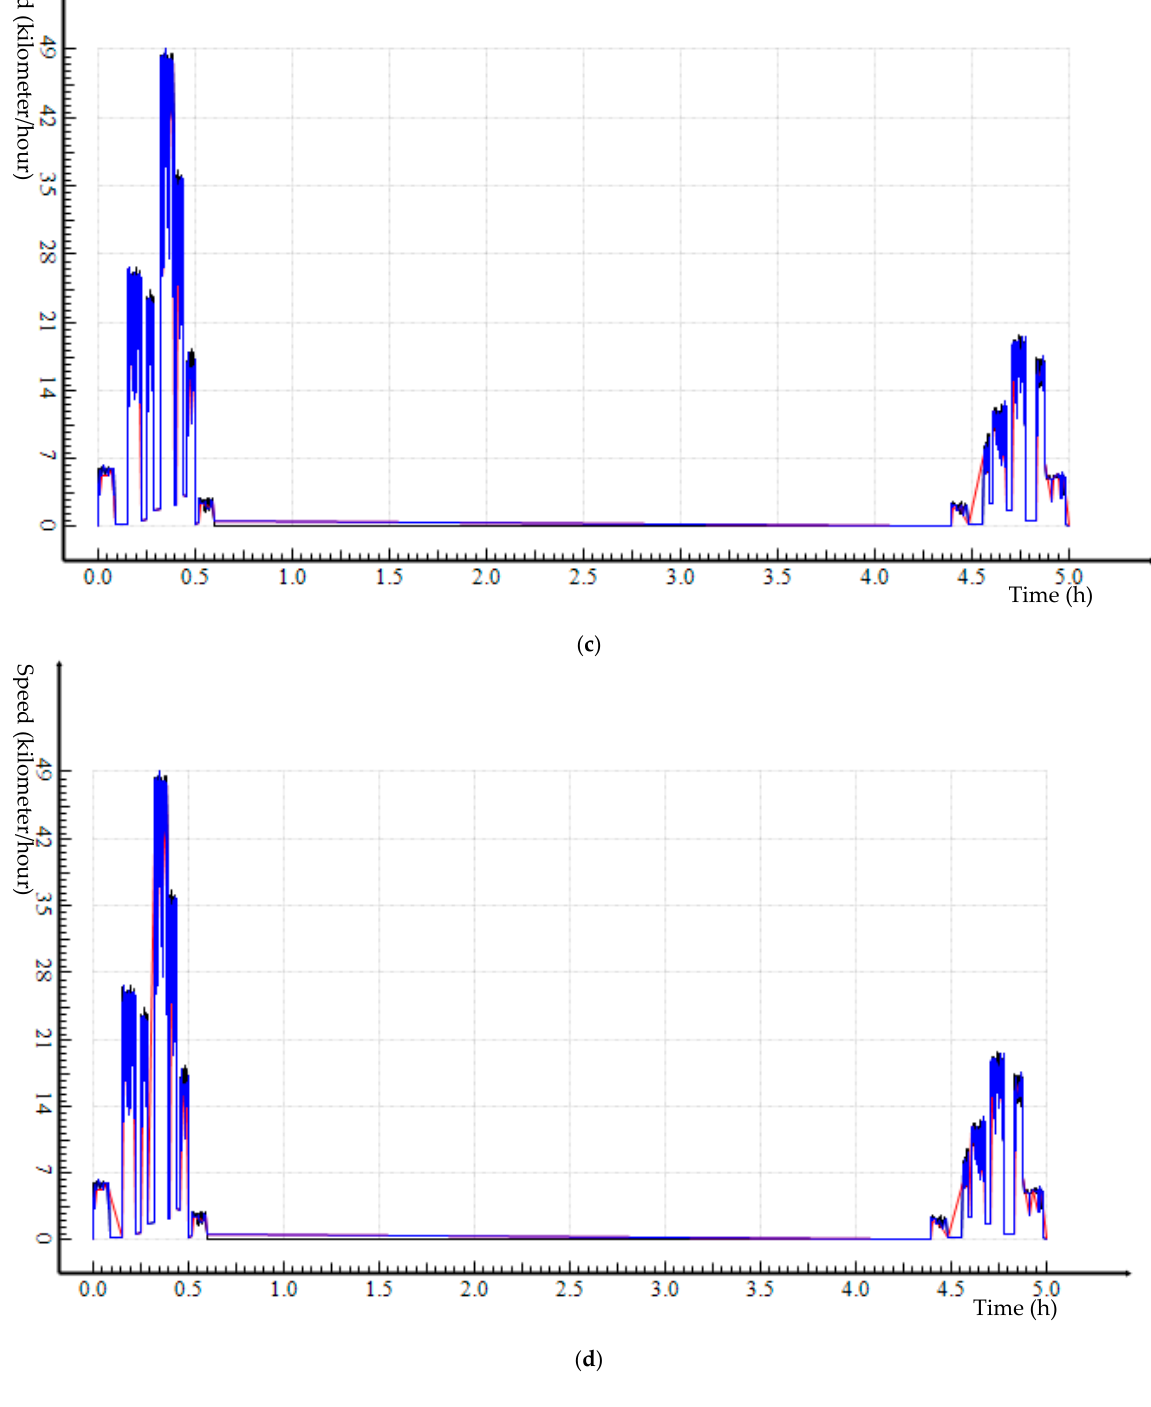
Figure 11. Speed–time graphs of the original Trajectory 2 data the simplified trajectory data based on DP and EDP algorithms with a distance threshold of: 1-m ( a ); 5-m ( b ); 10-m ( c ); and 25-m ( d ).